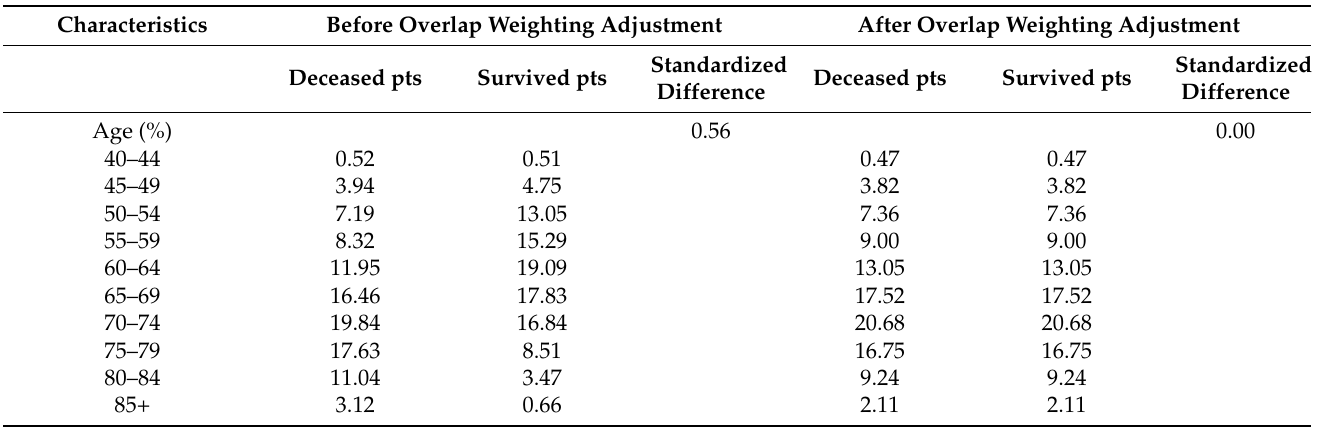
Table 3. Baseline characteristics of gastric cancer